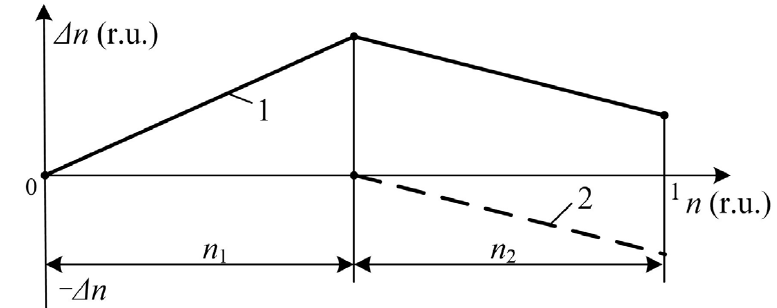
Figure 4. Dependence of the calculation error in the case of FL on OHPL: 1 corresponds to ∆ Z L 2 < 0; 2 corresponds to ∆ Z L 2 > 0.